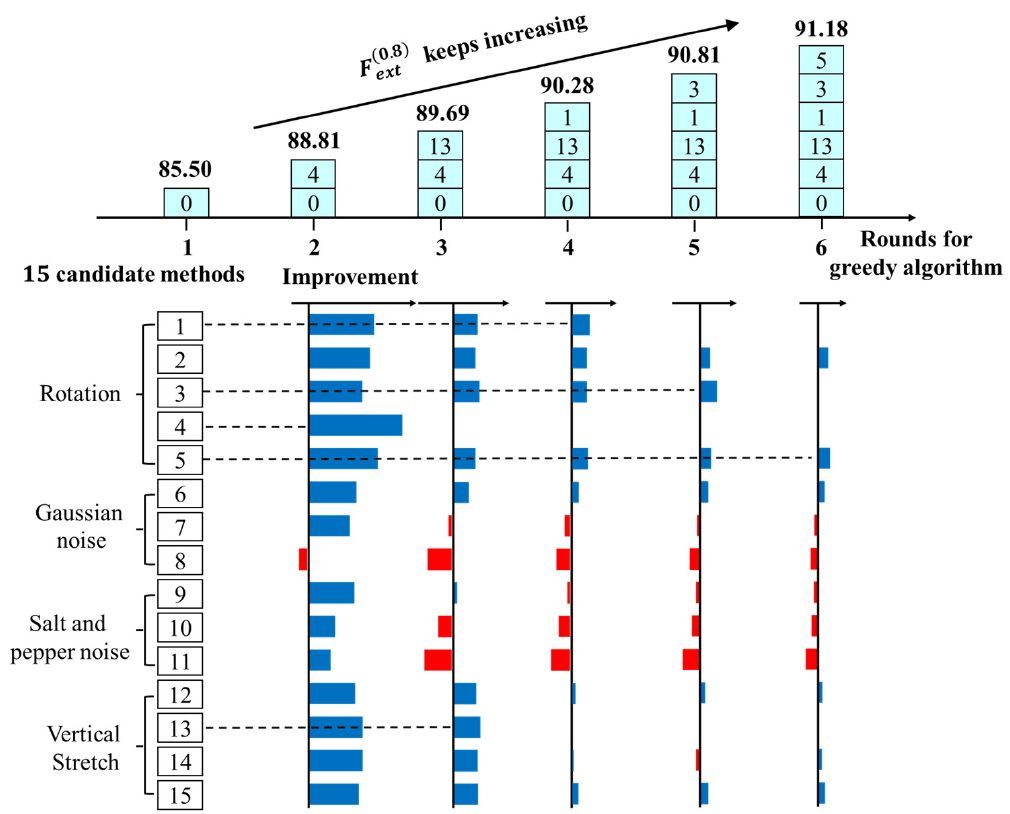
Figure 10. Search process and results of the greedy algorithm for the inference process. The rectangular box represents the candidate method, and the histogram indicates the improvement of the model when each method is added respectively. We select the method that obtains the maximum of the histogram in each round and add it to the final solutions being constructed. The sequence on the top shows the selected method added to the final solutions in different rounds by the greedy algorithm. Table 5. Search results of the greedy algorithm in the inference process. Rounds of the